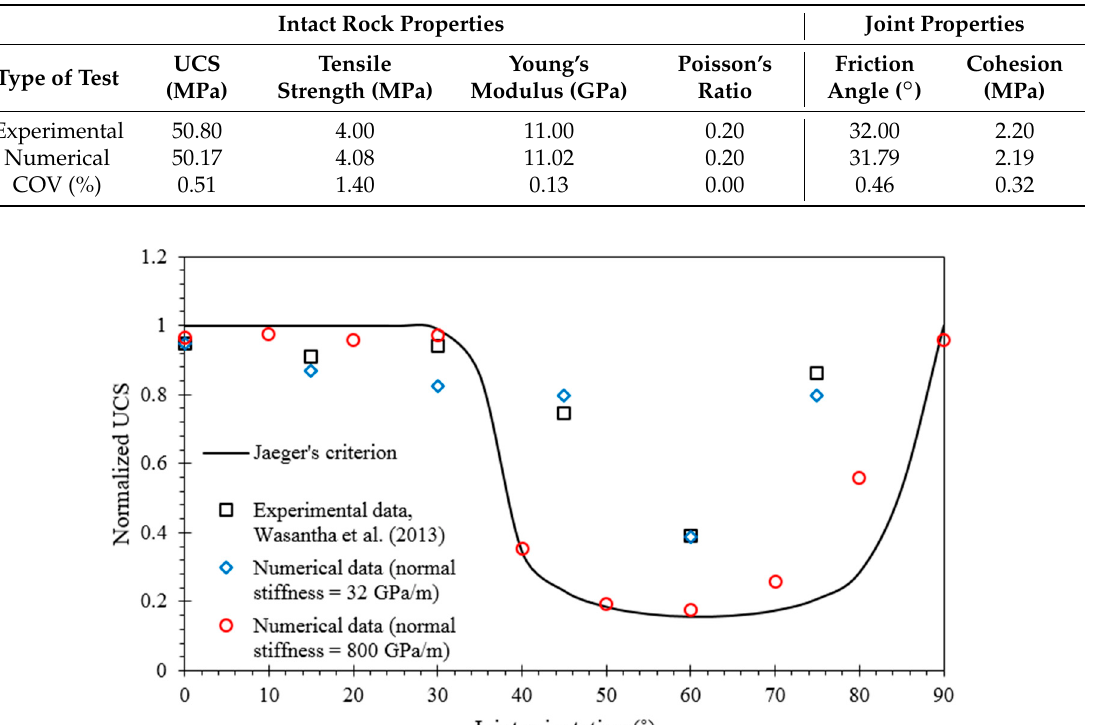
Figure 4. Comparison between the Jaeger’s criterion, experimental results [8] and numerical simulations.